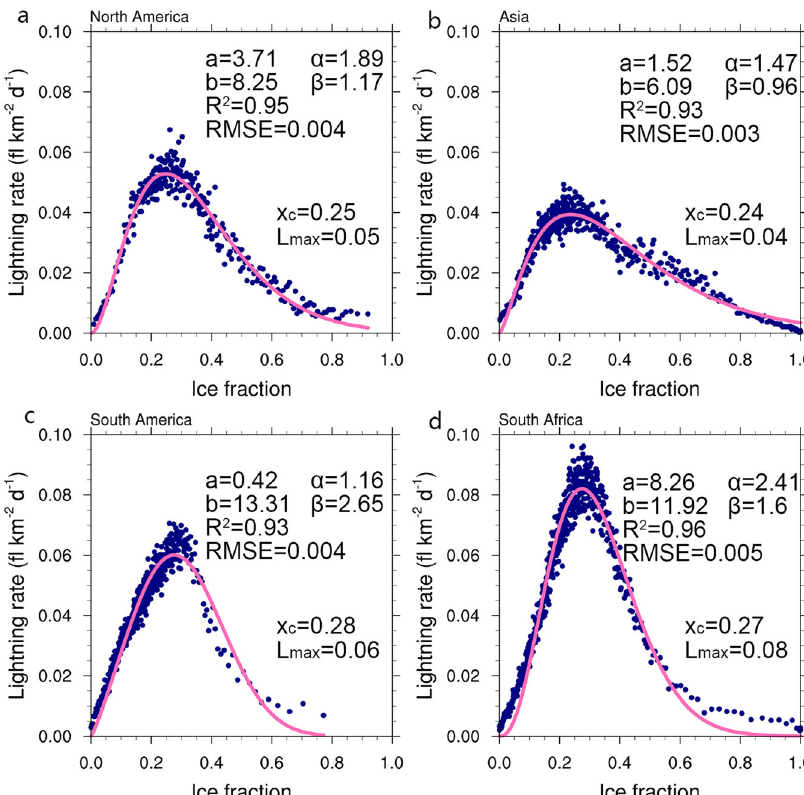
Fig. 6 Scatter plots of lightning fl ash rate versus cloud ice fraction in the four frequent lightning regions. a North America, b Asia, c South America, and d South Africa. In addition, lightning fl ash rate as a regression equation of cloud ice fraction (pink curves), the fi tting coef fi cients (a, α , b, and β in Eq. (1) ( “ Methods ” )), as well as the calculated x c and L max in the four regions are presented in the fi gures. R 2 and RMSE are goodness-of- fi t index and root mean square error,